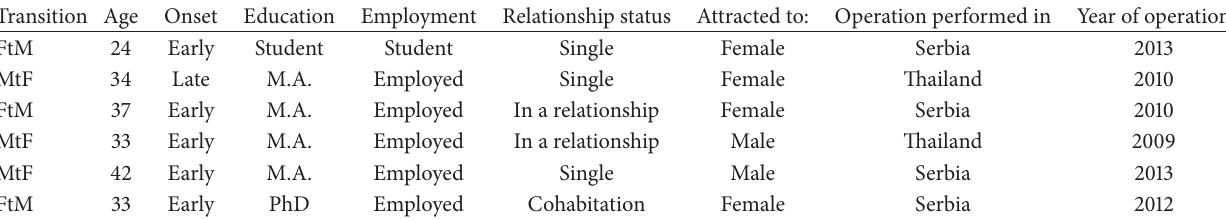
Table 1: Demographic characteristics of participants ( 𝑁 = 6